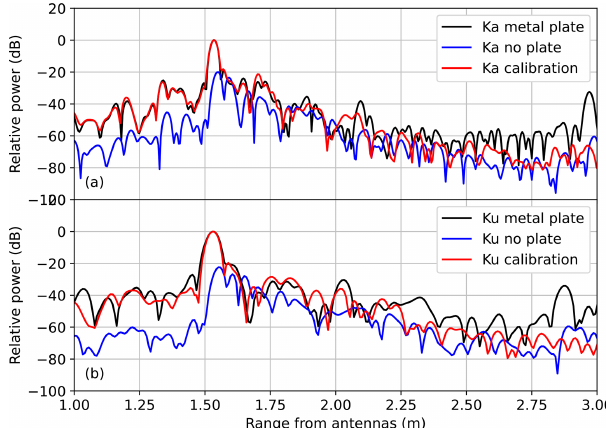
Figure 6. Radar returned power in the (a) Ka- and (b) Ku-bands. These data were gathered over the exposed snow and ice (blue); a metal plate on the snow surface, approximately 15 × 55cm (black); and the internal calibration loop (red). The calibration data have been shifted in range and power to correspond to the peak locations of the metal plate. The power that comes from above the air–snow interface within a few centimeters of the peak is simply the im- pulse response of the radar. The noisy power at the − 60dB level is probably a range sidelobe of the signal from the peak region. The range sidelobes at the − 23dB level and below (Ka-band) and at the − 30dB level (Ku-band) are due to internal reflections in the radar